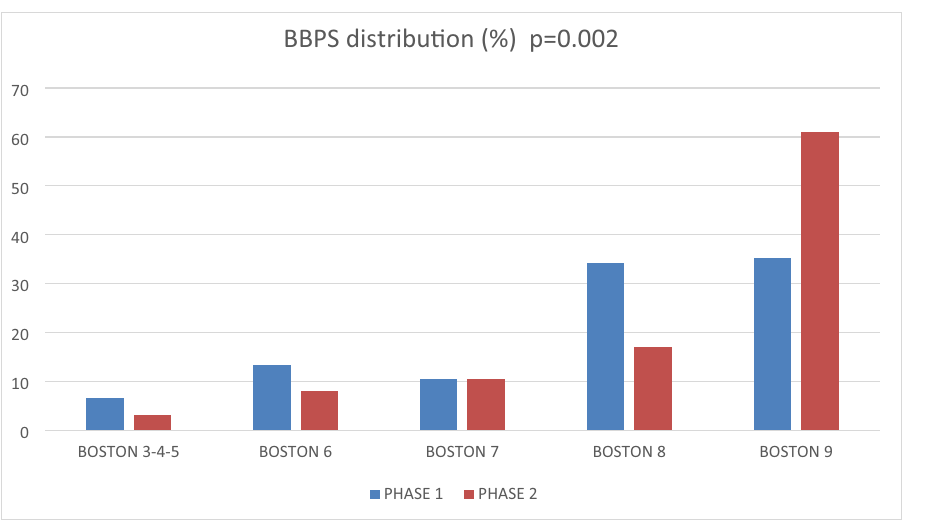
Figure 1. Boston Bowel Preparation Scale